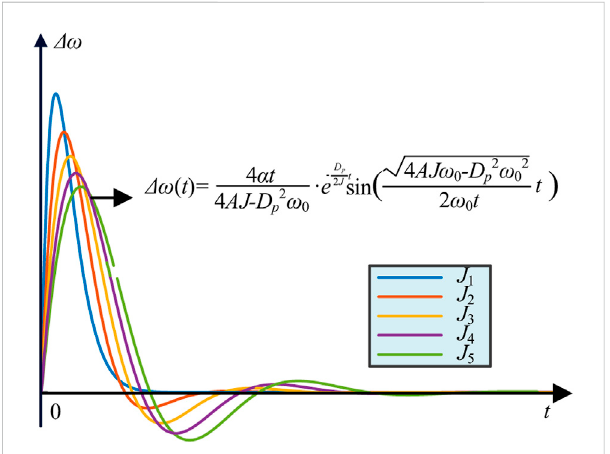
FIGURE 3 Frequency response under different virtual inertia values in the step change of active power reference value.